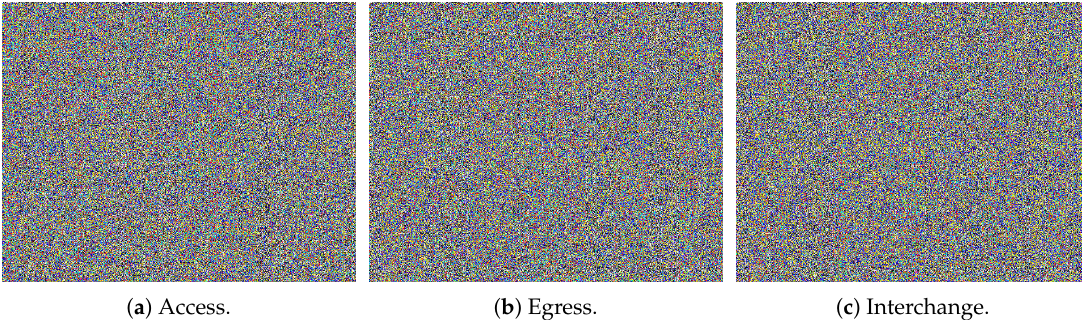
Figure 8. Encrypted text AEI